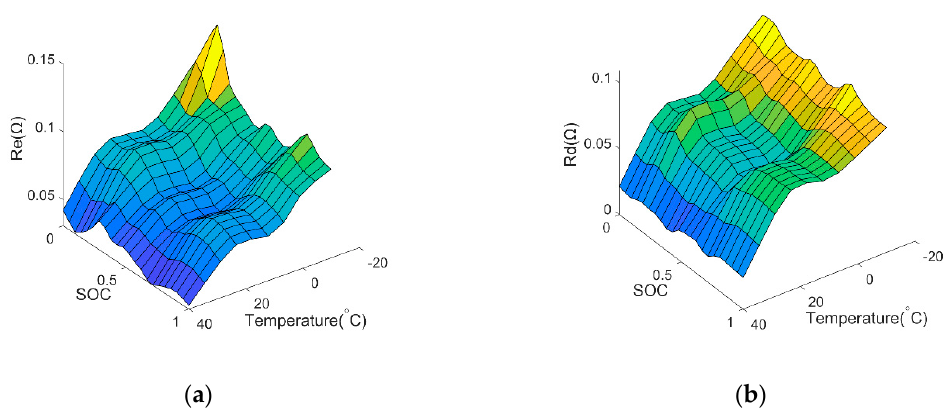
Figure 10. Polarization resistance identification results at different temperatures: ( a ) Electrochemical polarization resistance; ( b ) concentration polarization resistance.